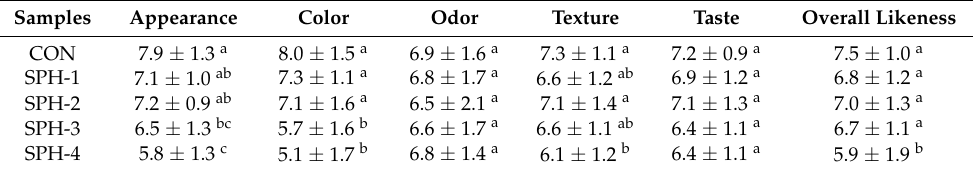
Table 1. Likeness score of thread bream surimi gels added without and with psyllium husk powder at various